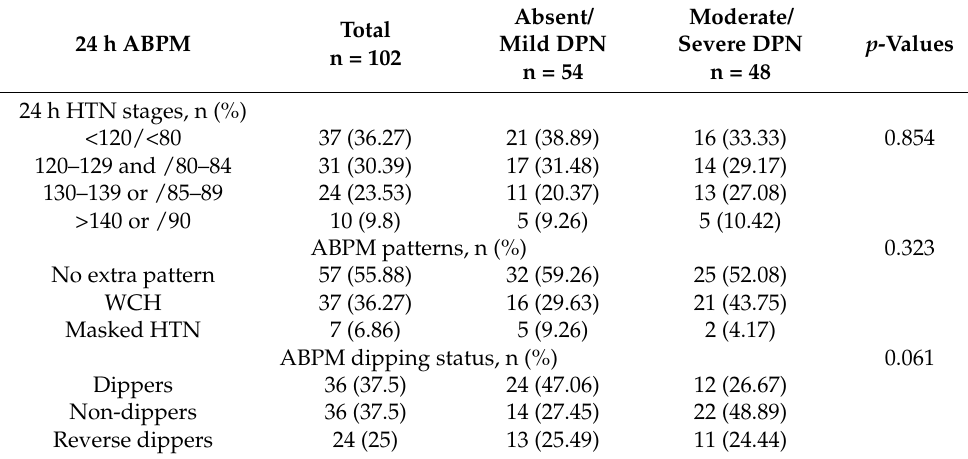
Table 3. Results of Pearson’s X 2 test for variables of the 24 h ABPM analysis.